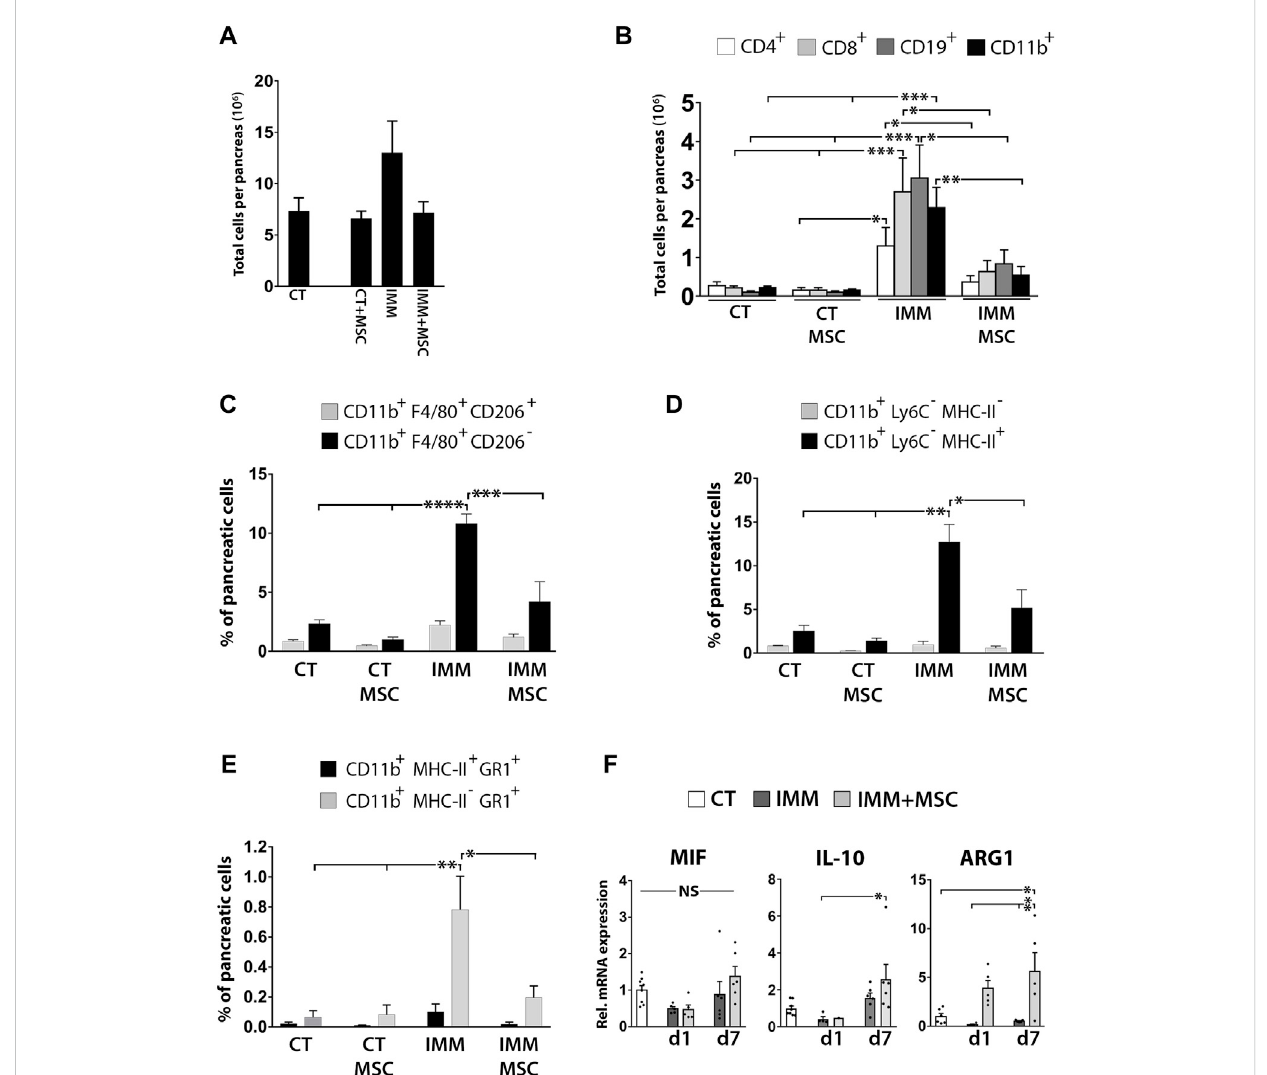
UC-MSC transplantation signi fi cantly reduces pancreatic leukocytes in fi ltration in IMM-RIP-B7.1 mice. (A) Total pancreatic stromal cells counts obtained from experimental groups at 7 weeks after UC-MSC transplantation. (B) Quanti fi cation of total numbers of CD4 + and CD8 + T Cells, CD19 + B Cells and CD11b + myeloid cells per pancreas in CT or IMM RIP-B7.1 mice at 7 weeks post-transplantation with vehicle or 5 × 10 5 UC-MSC. (C) Quanti fi cation of [CD11b + ;F4/80 + ;CD206 - ] and [CD11b + ;F4/80 + ;CD206 + ] pancreatic macrophages subsets. (D) Quanti fi cation of [CD11b + ;Ly6C − ; MHC-II - ] and [CD11b + ;Ly6C − ;MHC-II + ] pancreatic myeloid cells subsets. (E) Quanti fi cation of [CD11b + ;MHC-II + ;GR1 + ] and [CD11b + ;MHC-II - ;GR1 + ] pancreatic myeloid cells subsets. (A – E) Analysis performed onto pancreatic stromal cells were collected from CT- or IMM-RIP-B7.1 mice at 7 weeks post-transplantationwithvehicleor5×10 5 UC-MSC. (F) Q-PCRanalysisofMIF,IL-10andARG1mRNAexpressioninpancreaticstromalcellsfromCTand immunized RIP-B7.1 mice transplanted with vehicle (IMM) or 5 × 10 5 UC-MSC (IMM + MSC) at day 1 and 7 post-transplantation. Results show relative mRNA expression to CT mice (value set as 1). (B – F) Values are mean ± s. e.m of n ≥ 5 mice for each experimental group. *, p ≤ 0.05; **, p ≤ 0.03; ***, p ≤ 0.01, one-way ANOVA. NS is for not signi fi cant